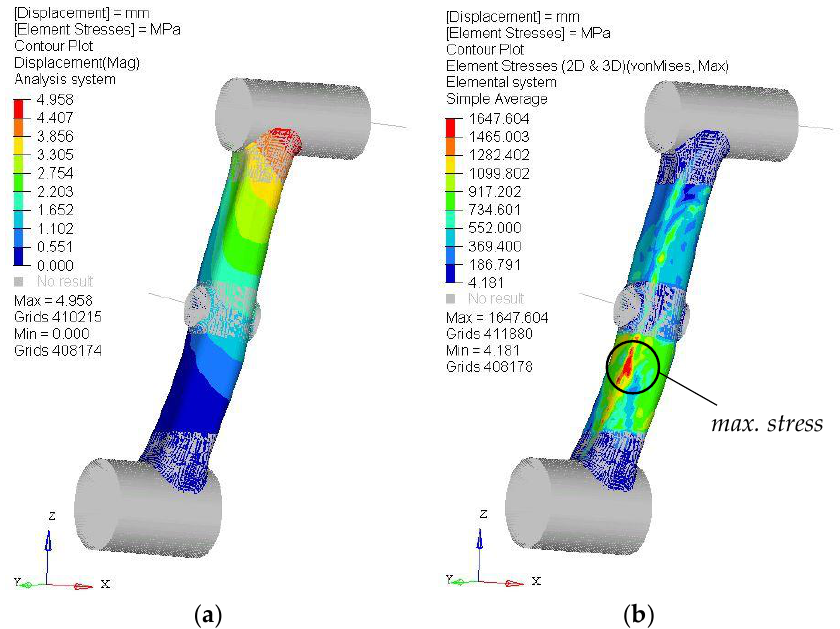
Figure 5. Linear static analysis of CFRP-structure containing a 2 mm TFP-structure; ( a ) element displacement [mm]; ( b ) element stresses